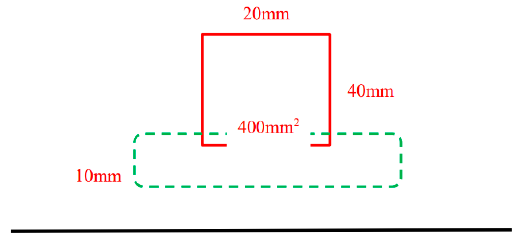
Figure 1. Schematic diagram of force deformation of gangue woven bags.